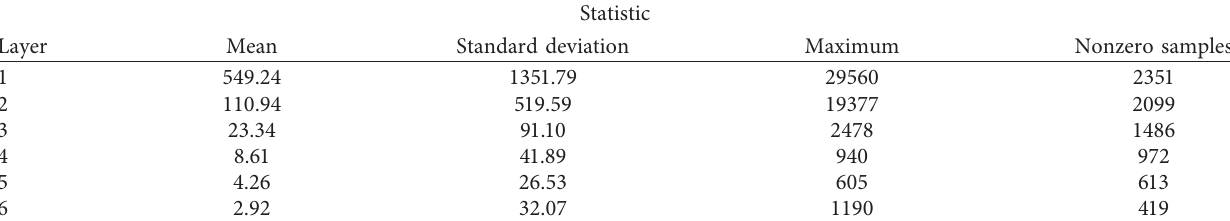
Table 2: Statistics of the number of nodes in each layer in the nonrumor propagation